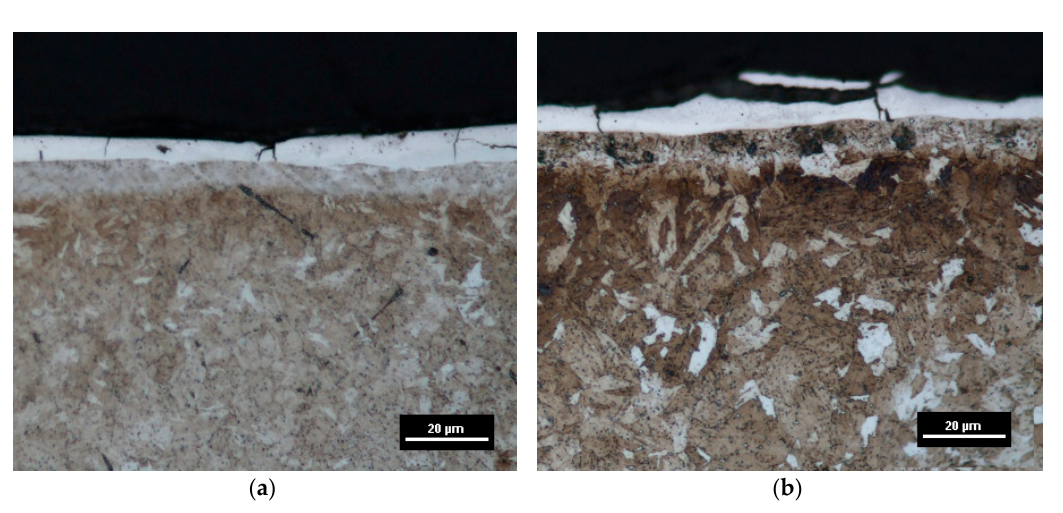
Figure 13. Metallographic structure: ( a ) sample with sequential processing; and ( b ) sample manufacturing only once with finishing parameters.